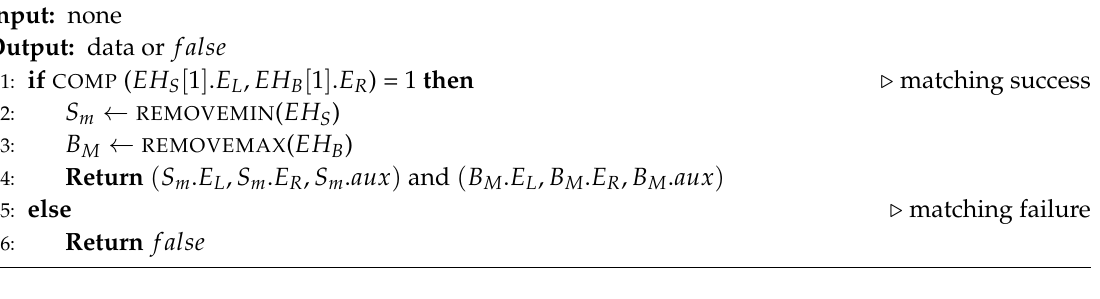
Algorithm 2 MATCHING procedure to find a possible match between a seller and a buyer.